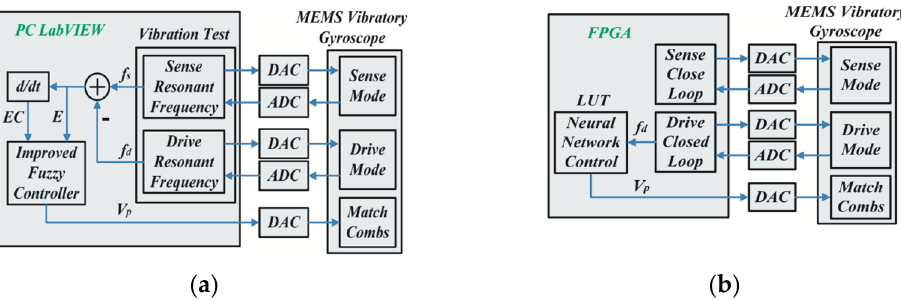
Figure 17. Mode-matching control method proposed by Peking University’s researchers: ( a ) block diagram of fuzzy control, and ( b ) block diagram of neural network algorithm.